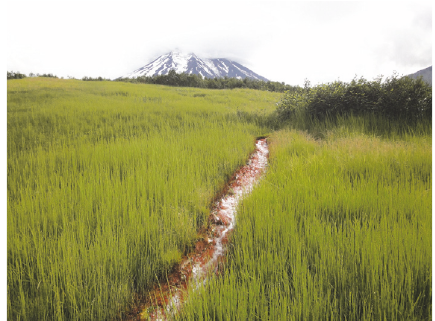
Figure23:KorykskyNarzan-1mineralhotspring(K1),August2016, Koryaksky Volcano is on a 7 km apart background. Photo by A. V. Kiryukhin.